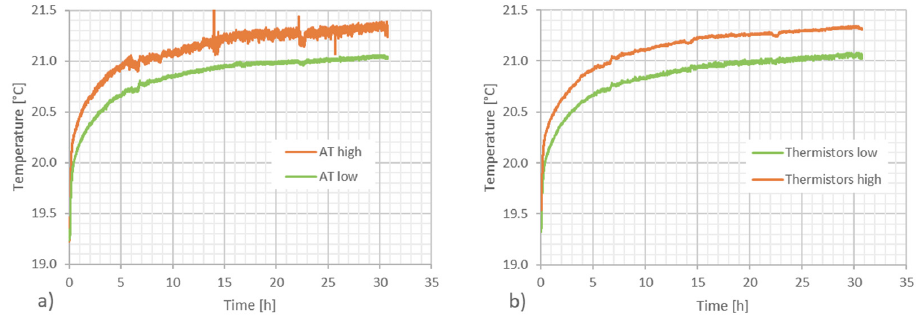
10 of 12 Figure 9. Picture of the experimental setup for the measurement of the vertical temperature gradient. In the foreground the two microphones and the screen of the LabView program used to analyze the data. The metrological gallery is 70 m long. Experiments at 60 m and at 26 m were performed successfully.